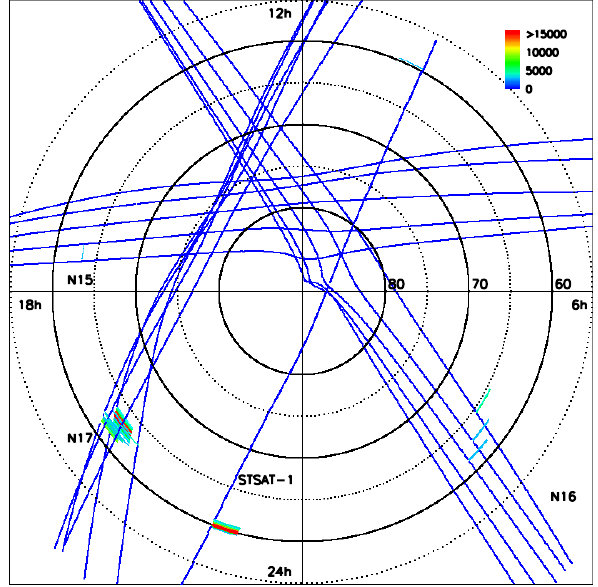
Fig. 8. Electron precipitations observed by four spacecraft, NOAA/POES N15, N16, N17 and